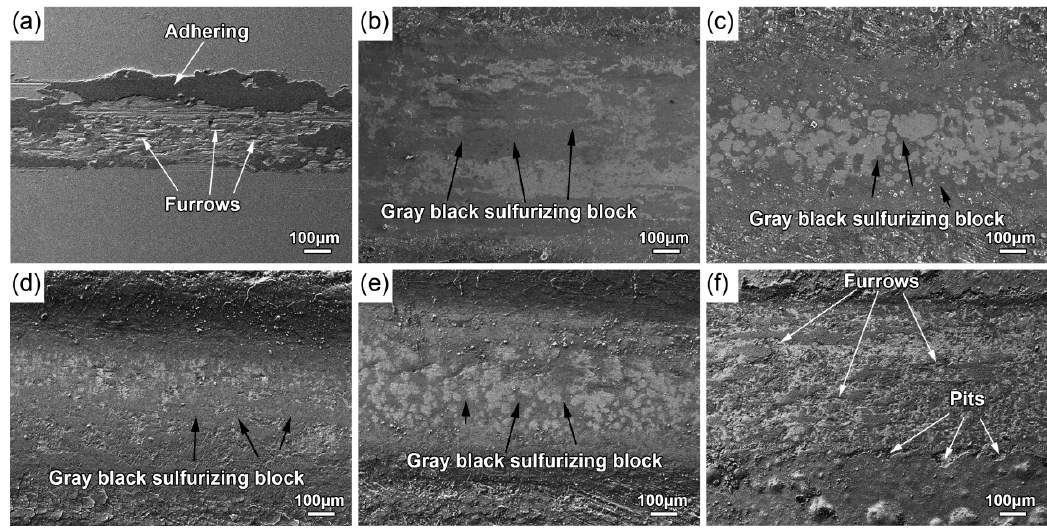
Figure 6. Wear morphology of various samples: ( a ) uncoated sample; ( b ) 30 °C; ( c ) 40 °C; ( d ) 50 °C; ( e ) 70 °C; ( f ) 90 °C.